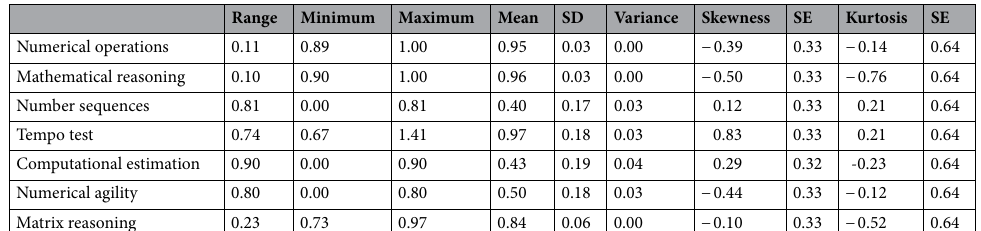
Table 1. Descriptive statistics, displayed in the first row, of the cognitive measures. SD, standard deviation; SE, standard error.